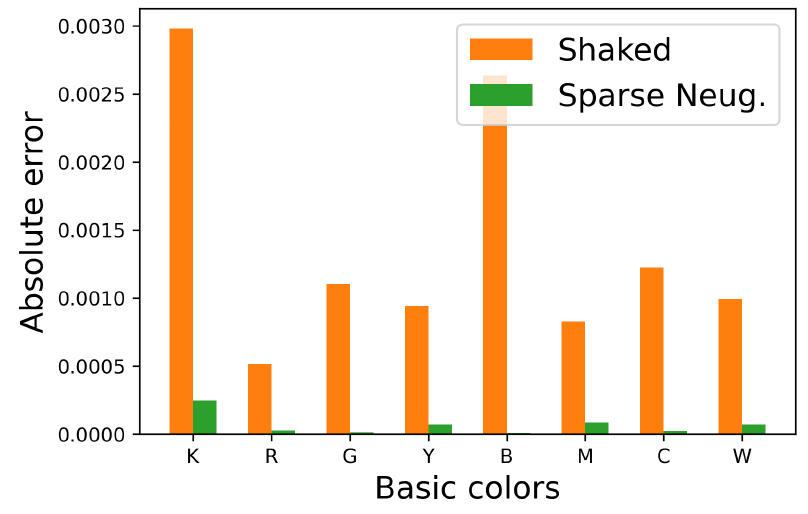
Figure 14. Absolute errors in occurrence probabilities in Figure